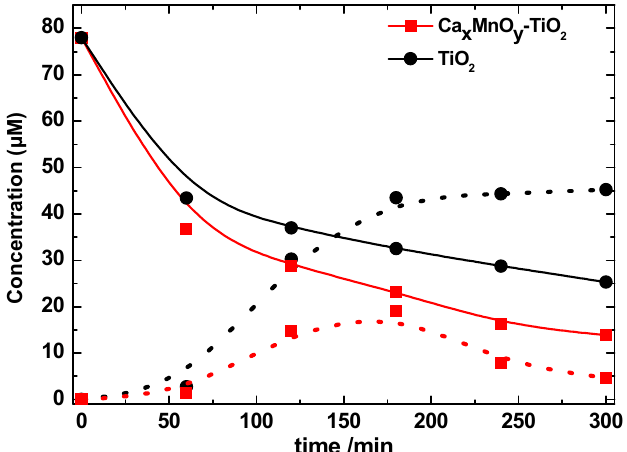
Figure 13. Evolution of concentrations of Imazapyr (solid line) and total intermediates (dots) upon photocatalysis onto Ca x MnO y -TiO 2 (I2) and TiO 2 (I1), as determined by MS-ESI.